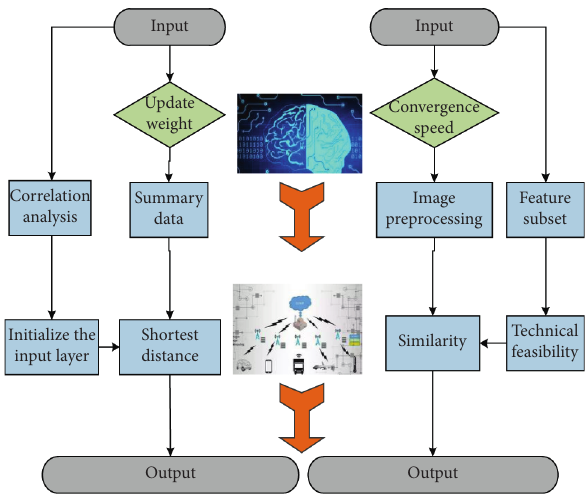
Figure 2: Distributed image recognition algorithm